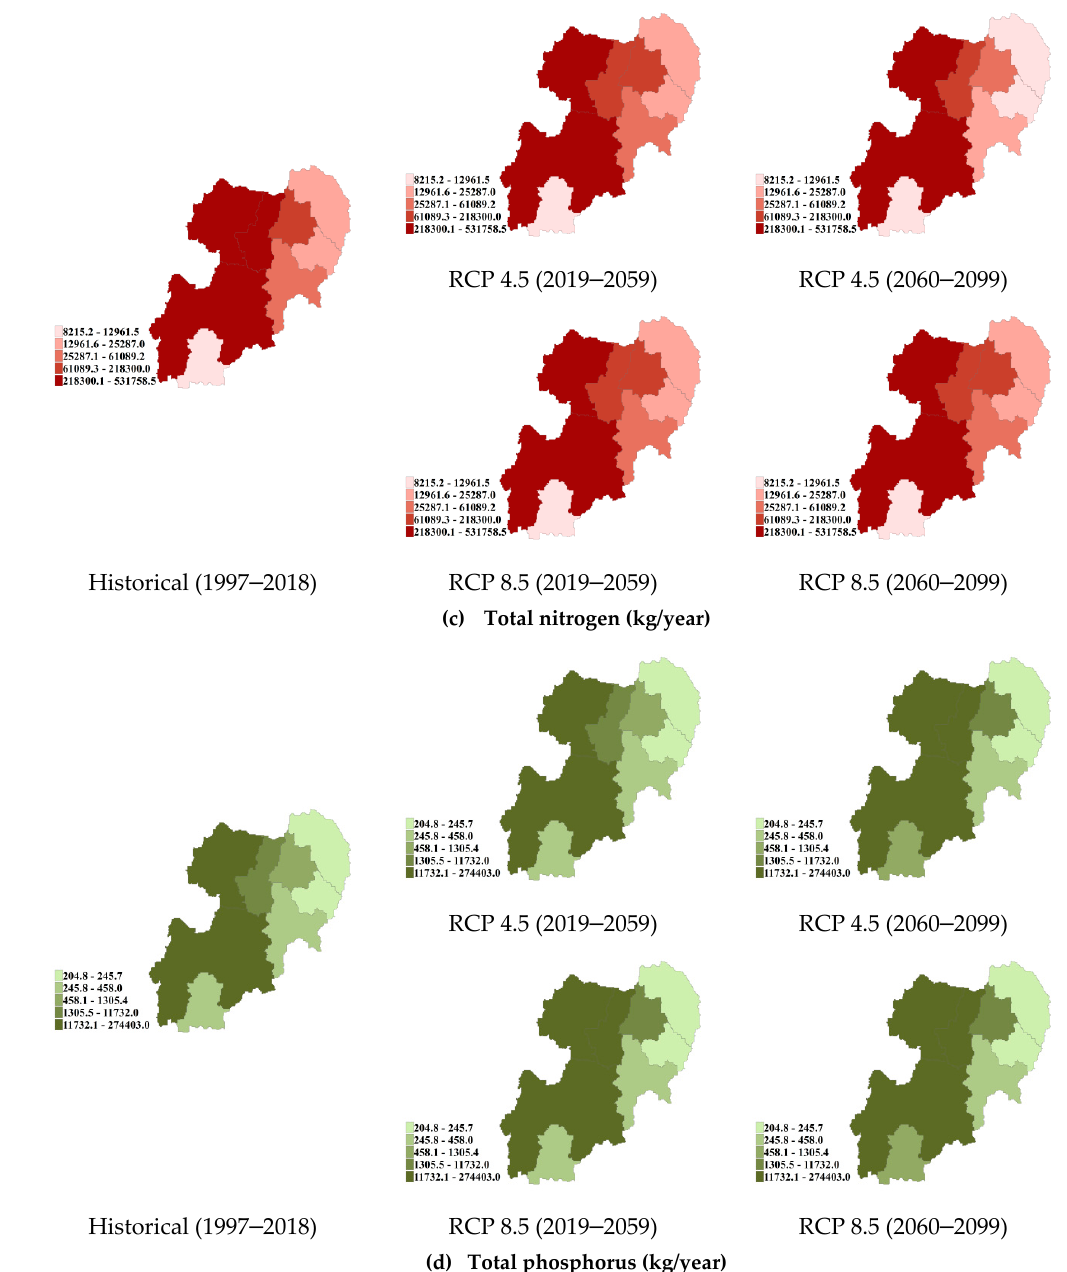
Figure 7. Spatial distribution of future ( a ) streamflow, ( b ) sediment, ( c ) total nitrogen, and ( d ) phosphorus loads during two time periods (2019–59 and 2060–99) relative to baseline (1997–2018) under two climate change scenarios: RCP 4.5 and RCP 8.5. Table 6. Monthly average streamflow, sediment, and total nitrogen (TN) and total phosphorus (TP) loads under two representative concentration pathway (RCP) climate changes scenarios.